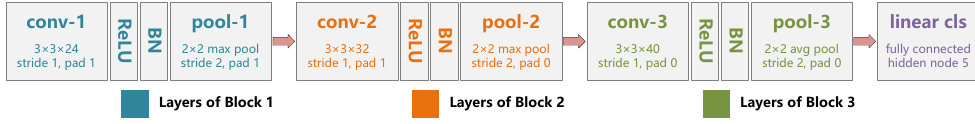
Figure 2. The architecture of the feature encoder and classifier. Layers within different blocks are represented by different